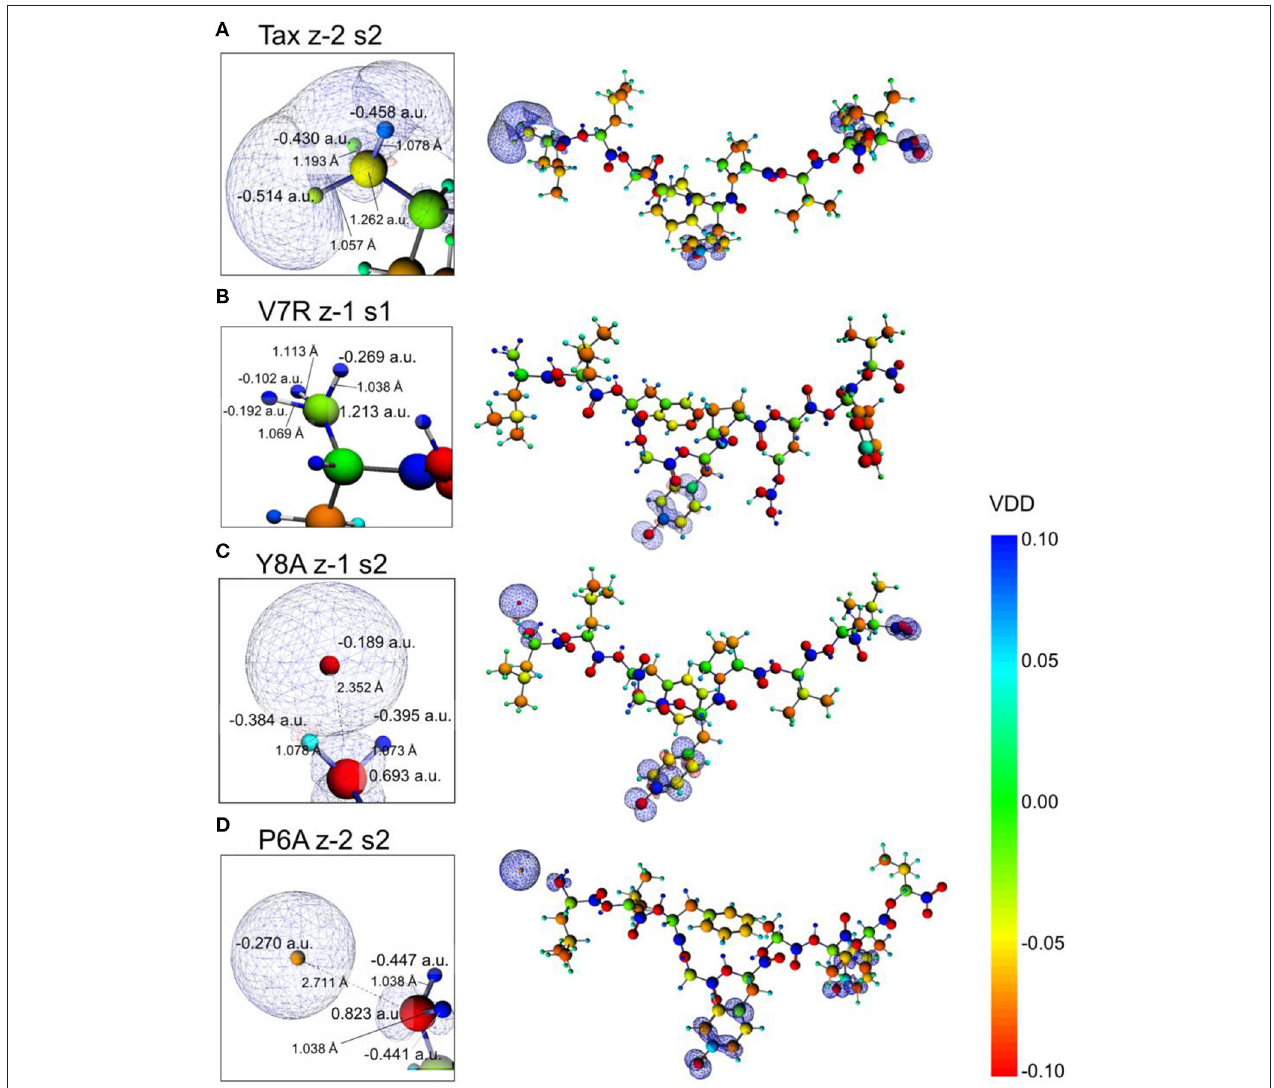
FIGURE 10 | Voronoi deformation density (VDD) and spin density of selected spin polarized peptides. From (A–D) : Tax (charge -2, polarization 2), V7R, Y8A, and P6A (charge -2, polarization 2). All peptides had a formal charge of -2 and a spin polarization of 2 except V7R for which these quantities were -1 and 1, respectively. On all structures the terminal hydroxyl groups of the triggering side chains were deprotonated. Every inset depicts a magnification of the peptide N terminus, which shows atom Voronoi charges and bond lengths. All spin density surfaces are drawn at 0.002 a.u. The VDD bar values are also in a.u.